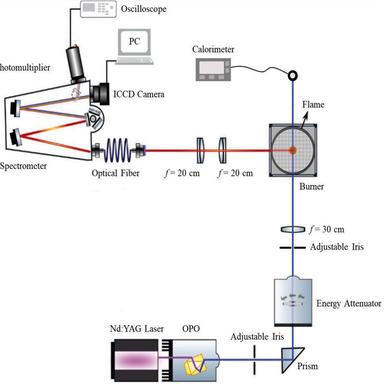
Schematic of the LIF measurements setup.